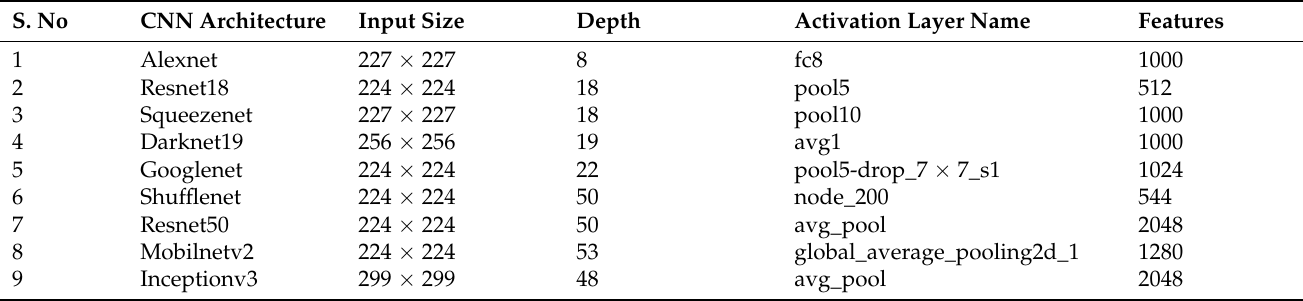
Table 9. Deep features extractor models details.